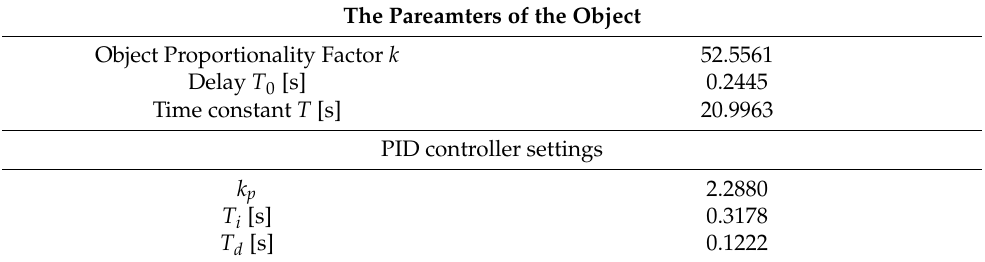
Figure 15. The approximation of the parameters of the fluctuating response of an object described with the following dependency (25). Table 3. The determined parameters of the fluctuating response of the object (25) and calculated PID controller settings.